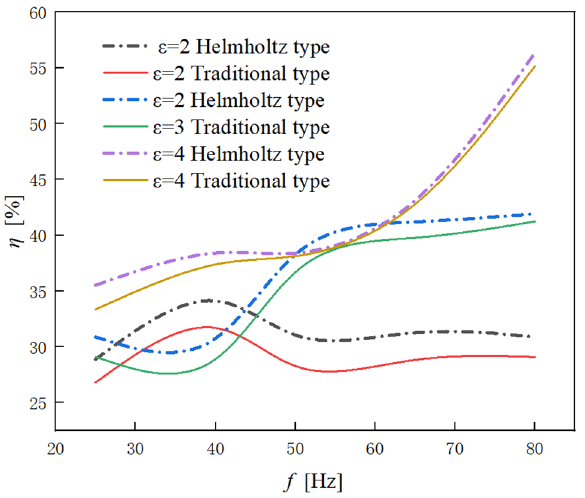
Figure 11. The refrigeration efficiency of the two types of gas wave tubes numerically simulated with the change of the ejection frequency.